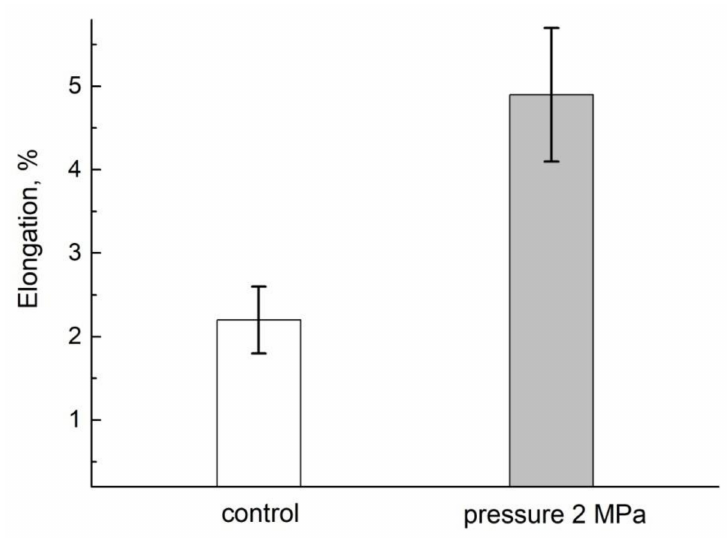
Figure 18. The increase (in per cent) in root segment length 4.5 h after cutting off at 23 ◦ C and the atmosphere pressure (control) and under the treatment with the air pressure of MPa [94].